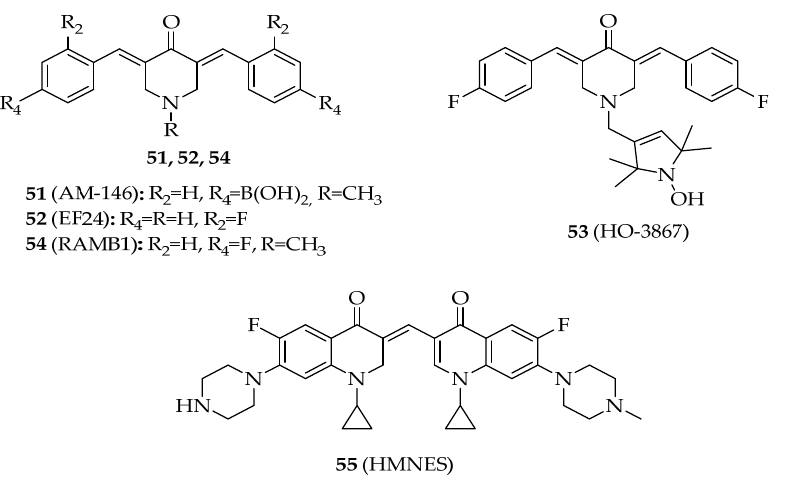
Figure 7. Structure of chalcone analogues 51 – 55 .